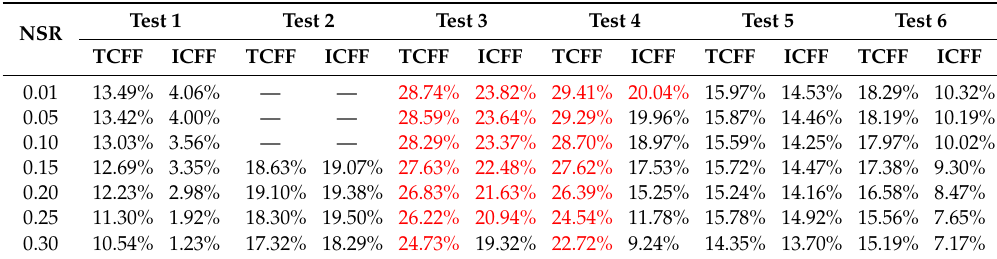
Table 4. Mean relative error of the amplitude identification following NSR